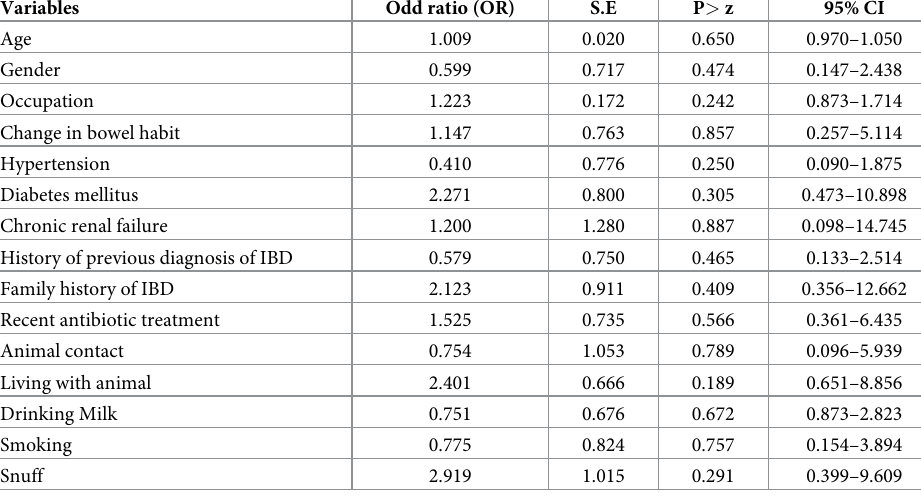
Table 2. Logistic regression model of factors associated with positivity to Mycobacterium avium subsp. paratuber- culosis (MAP+) in samples of patients with gastrointestinal